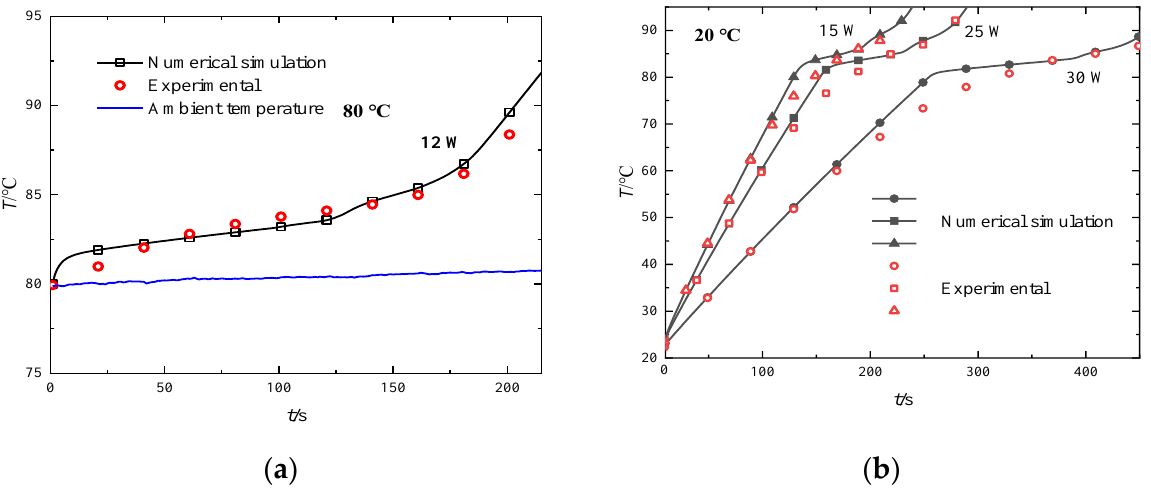
Figure 5. Temperature profiles of higher alcohol/graphite foam-based heat sink. ( a ) Temperature profile of heat source at 80 °C 12 W. ( b ) Temperature profiles of heat source at 80 °C for varied powers.